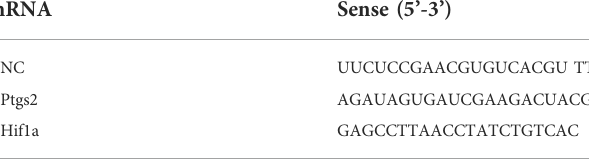
TABLE 1 shRNA used in the